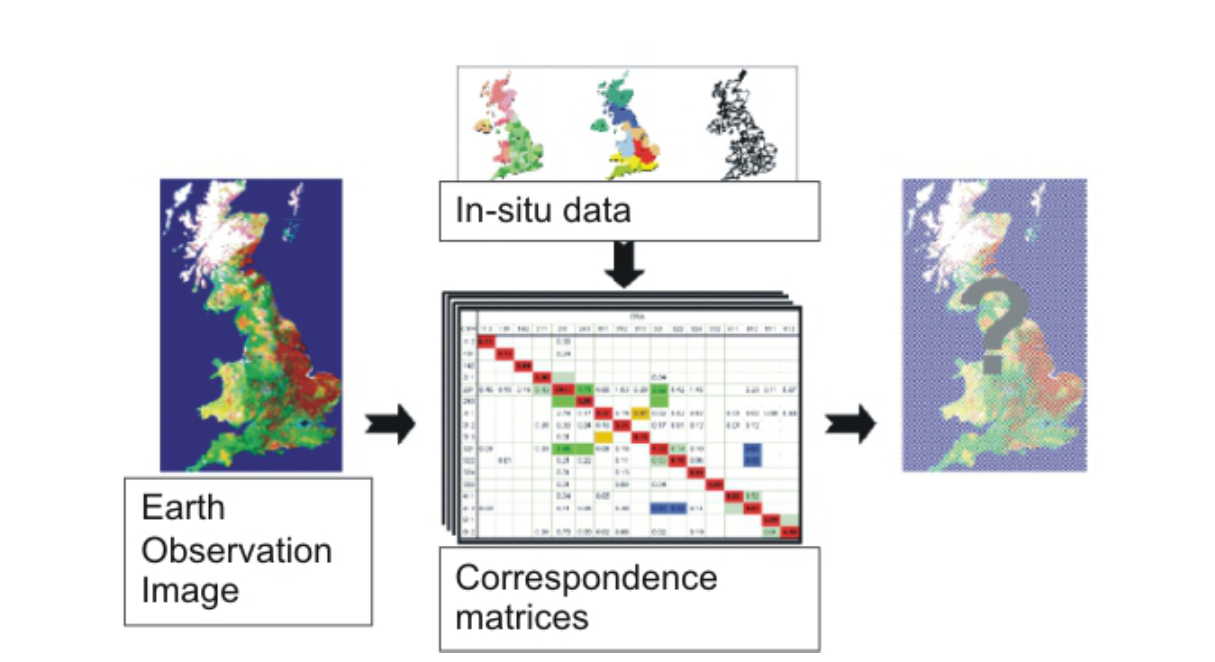
Fig. 2 . A visualization of the intercalibration procedure (adapted from http://www.EBONE.wur.nl/UK/ Project+Work+Packages/WP5+Inter-calibration/, accessed March 16, 2010). The question mark indicates EBONE’s